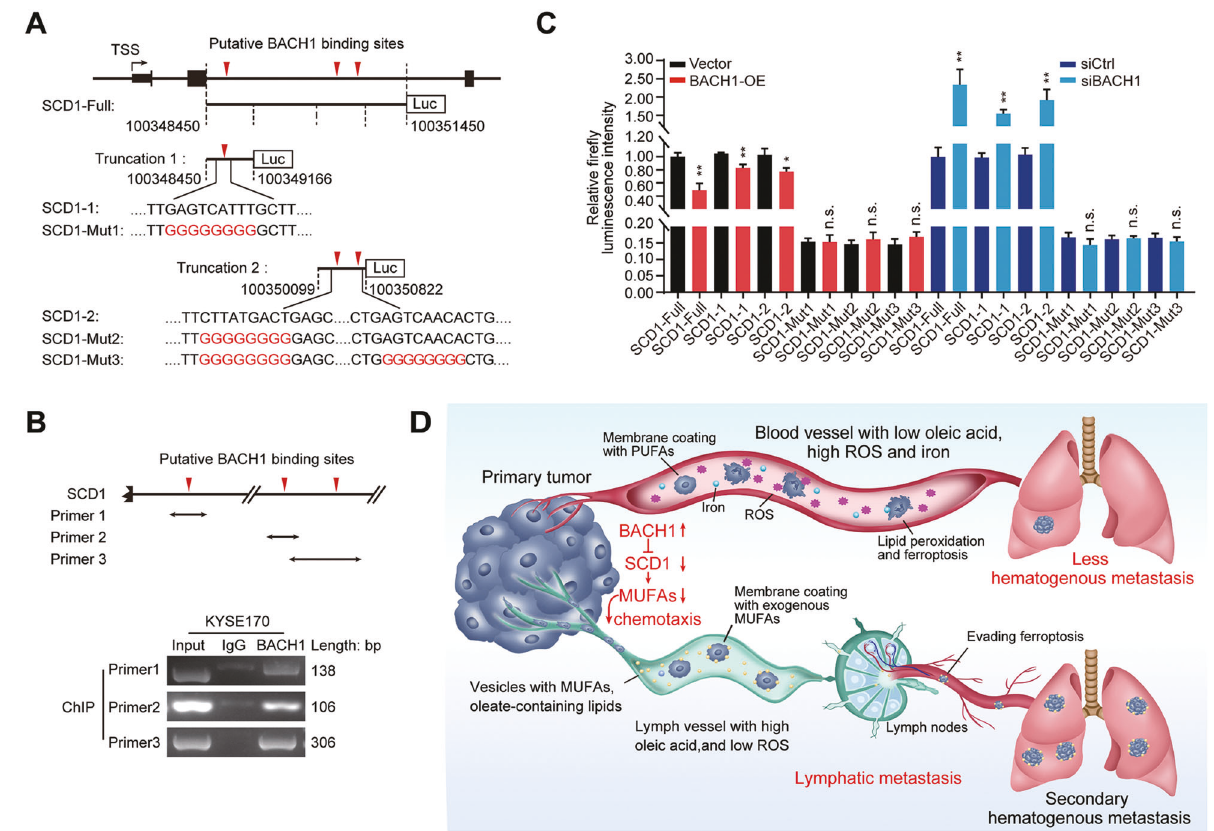
Fig. 7 BACH1 transcriptionally inhibited SCD1 promoting ferroptosis and lymph node metastasis. A Schematics of luciferase reporters containing the full (3 kb; SCD1-Full), truncated (SCD1-1 and SCD1-2) and mutant (SCD1-Mut1, SCD1-Mut2, and SCD1-Mut3) sequences (3 kb) of three predicted BACH1 binding motifs in the intron 2 region of the SCD1 gene ~1.3 – 3.5 kb downstream of the transcription start sites (TSSs). The upside-down red triangles represent the predicted putative BACH1 binding motifs based on the JASPAR database. B ChIP-PCR assays indicated that BACH1 was bound to the intron 2 region of SCD1 through the three putative binding sites. The potential BACH1-DNA complex was immunoprecipitated from KYSE170 cells with an anti-BACH1 antibody, and the three binding regions in SCD1 were ampli fi ed by PCR. The PCR primers are labeled with double arrows in the schematics (top panel). C The fi re fl y luciferase activity in KYSE170 cells cotransfected with the indicated plasmids or siRNAs with luciferase reporters, revealing that BACH1 binds to SCD1. D The basic mechanism by which BACH1 promotes ferroptosis and lymph node metastasis. In BACH1-overexpressing tumors, BACH1 reduces the content of OA in cell membranes by inhibiting SCD1, the rate-limiting enzyme for MUFA biosynthesis, resulting in tumor cell susceptibility to ferroptosis. Thus, hematogenous metastasis of tumor cells is inef fi cient because of the high levels of iron ions and oxidative stress in the blood. By contrast, since lymph fl uid, which is rich in MUFAs, lymph fl uid chemoattracts tumor cells with a low MUFA content to enter the lymphatic tracts. The cells are then wrapped by a protective layer of MUFAs, which enables them to escape ferroptosis. These processes increase the survival ability of tumor cells during subsequent dissemination through the blood, leading to multistation lymph node metastasis as well as secondary hematogenous metastasis. *, P < 0.05; **, P < 0.01; ***, P <